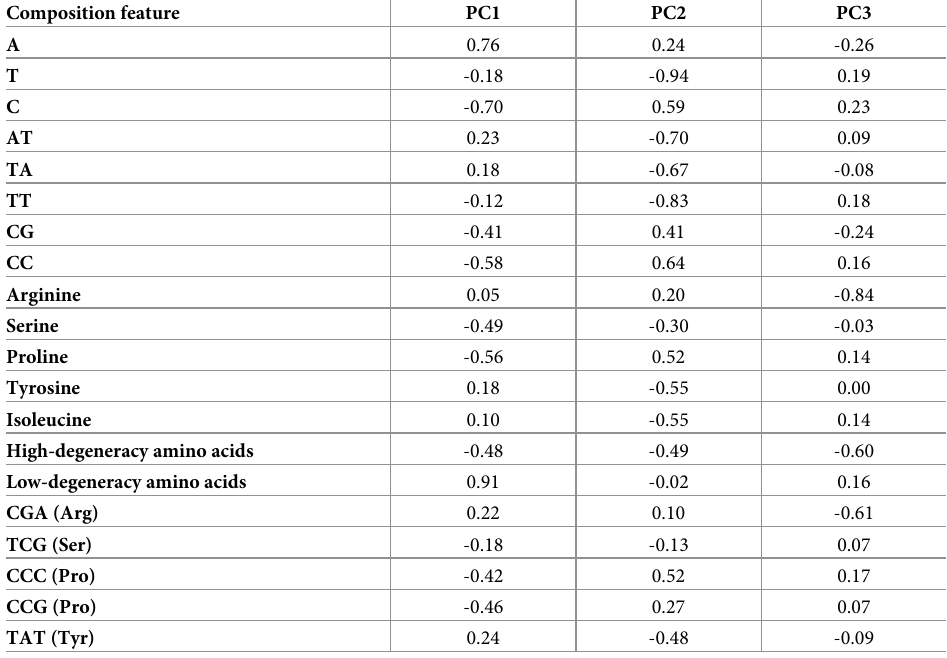
Table 4. Correlation between the 20 critical composition features of overlapping genes and the first (PC1), second (PC2), and third (PC3) principal component. Composition